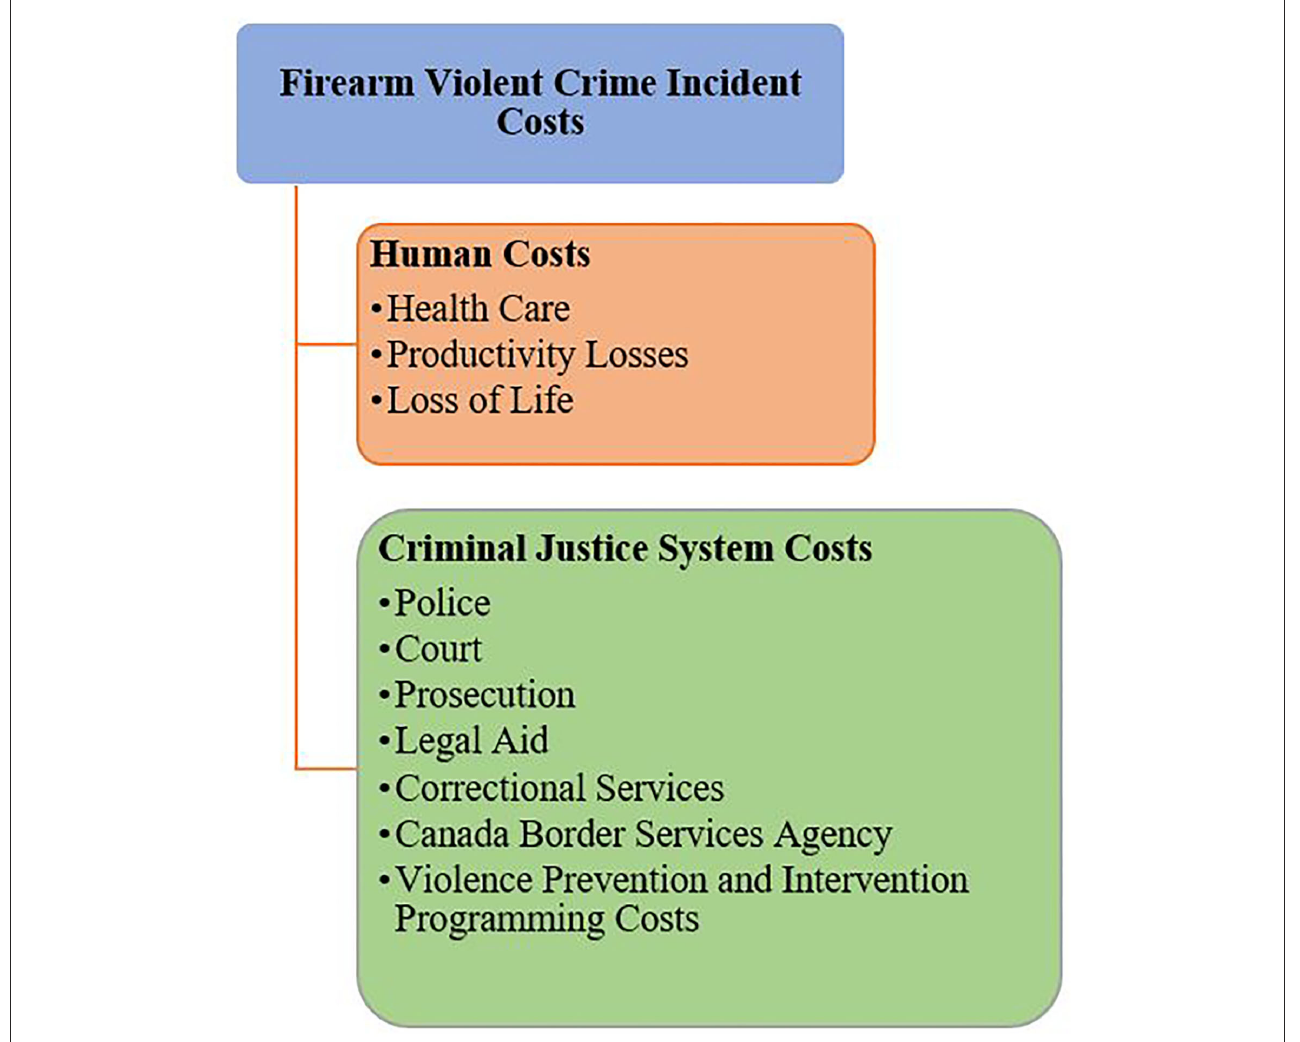
FIGURE1 Categorization of firearm violent crime incident